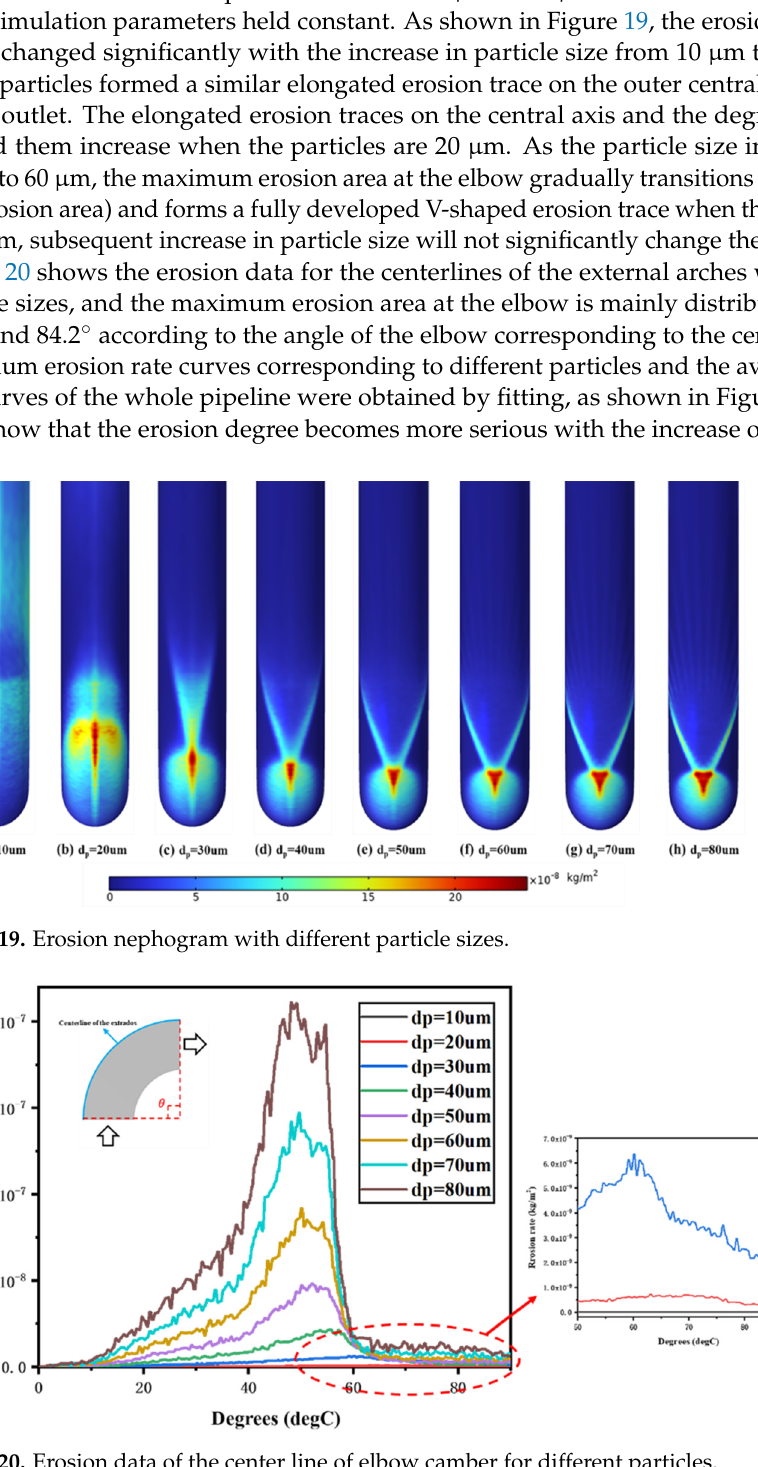
Figure 20. Erosion data of the center line of elbow camber for different particles.